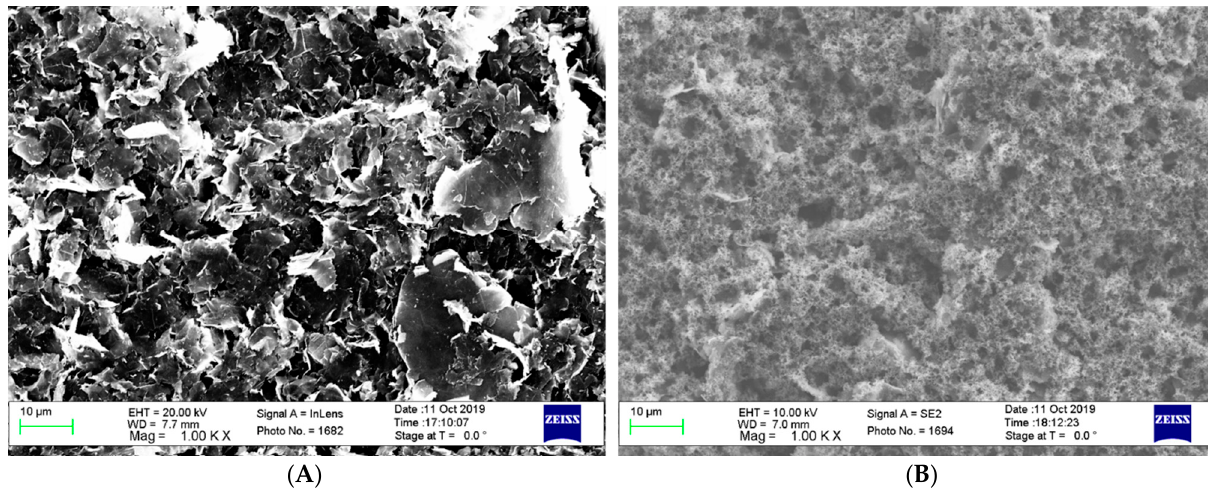
Figure 3. Surface morphology using SEM ( A ) unchanged graphene; ( B ) graphene altered with PANI.